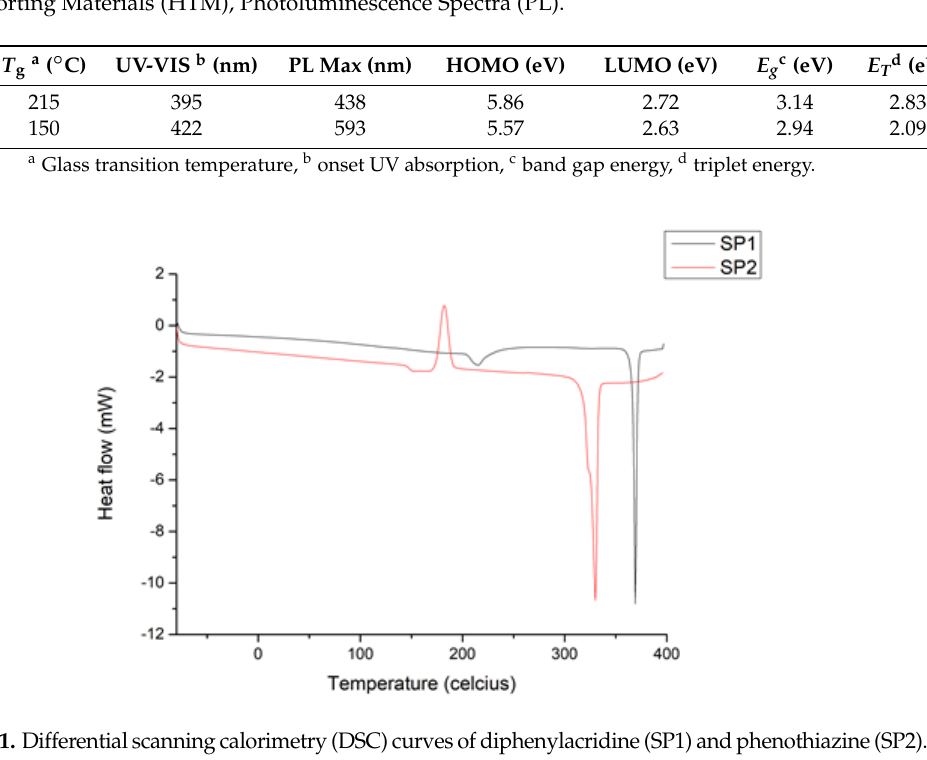
Table 1. Thermal and physical properties of diphenylacridine (SP1) and phenothiazine (SP2). Hole Transporting Materials (HTM), Photoluminescence Spectra (PL).